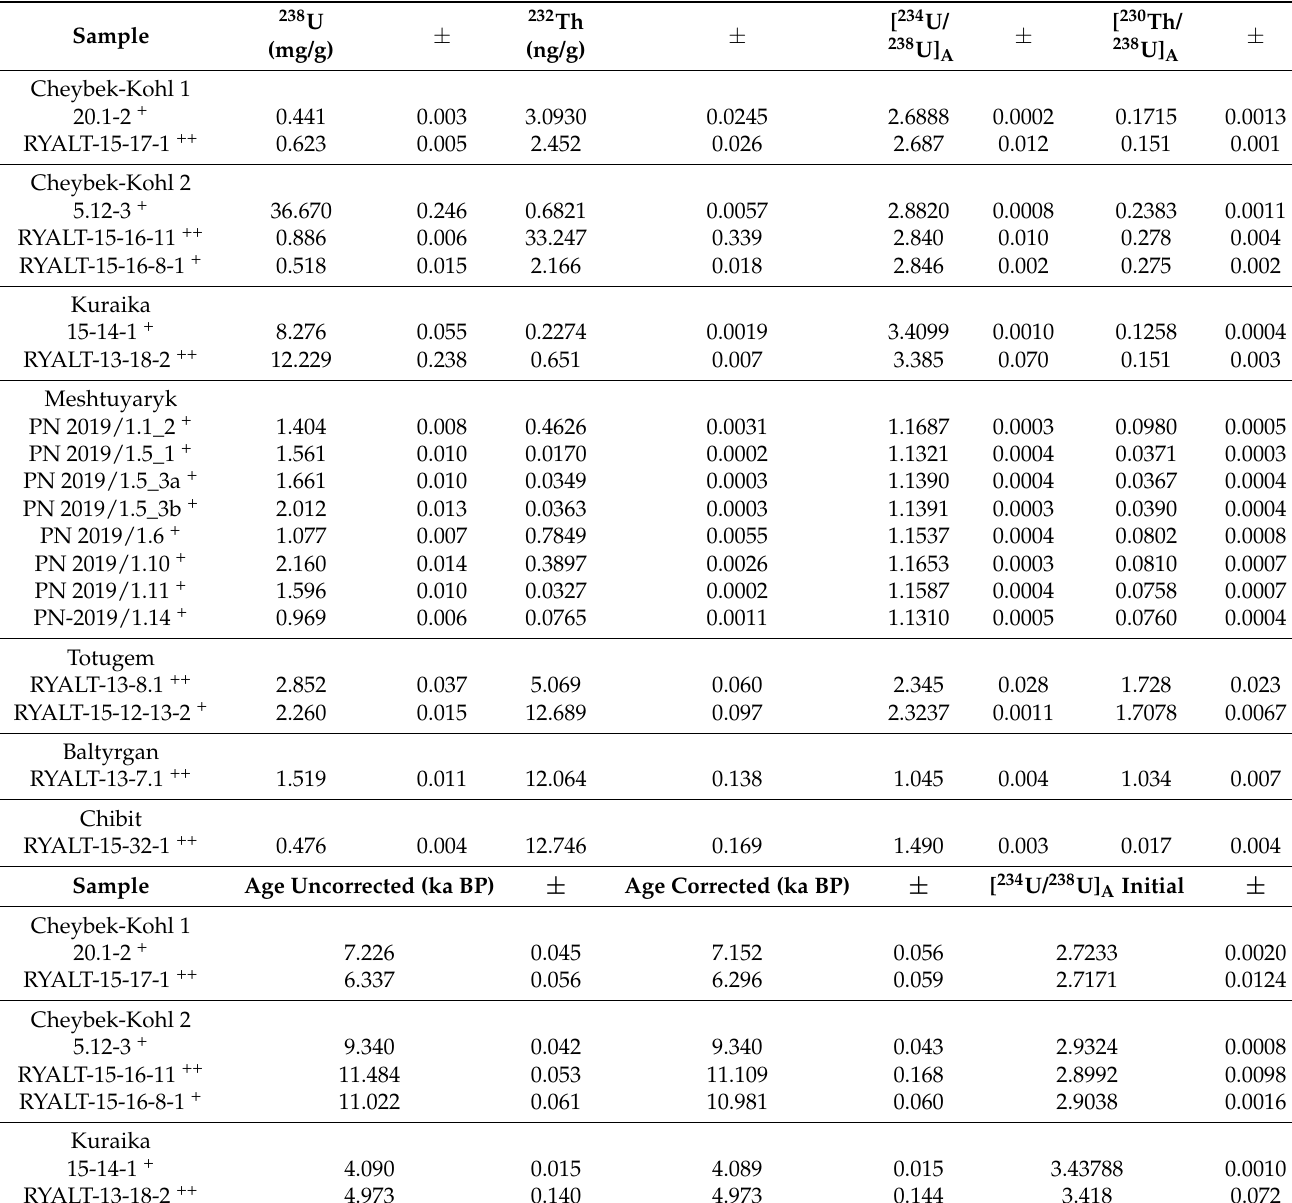
Table 4. 230 Th-U ages of travertines from the south-eastern Gorny Altai, data from